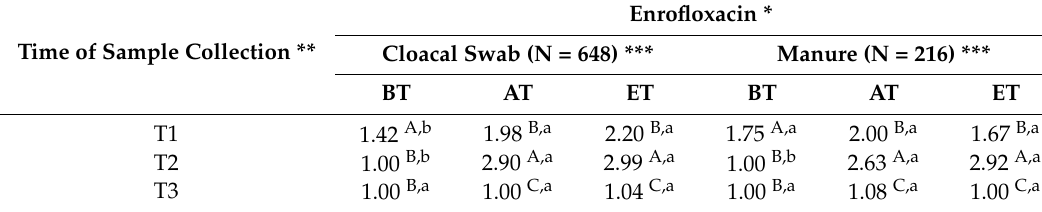
Table 1. Means of enrofloxacin-resistant E. coli isolates from cloacal swab and manure samples from turkeys.